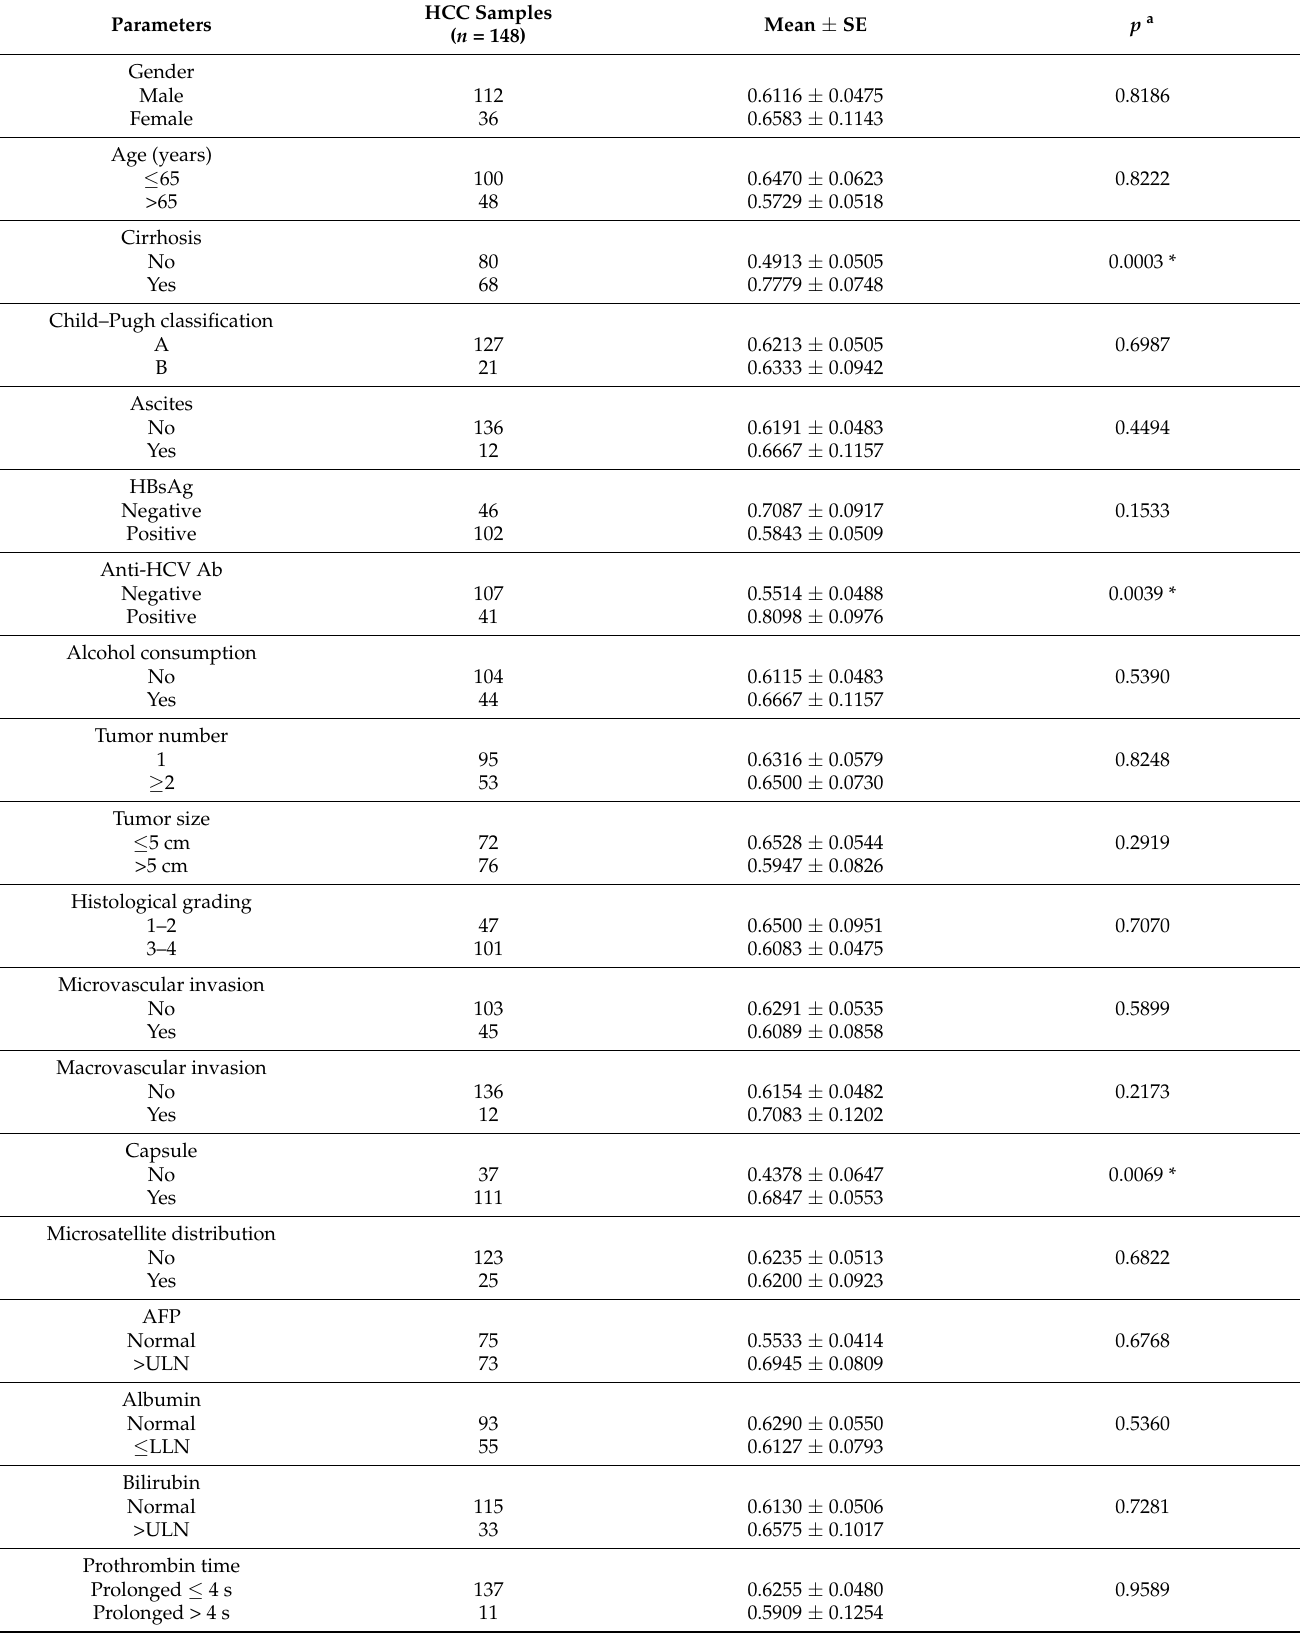
Table 2. Clinicopathological correlations of ANXA2 in HCC specimens (cohort